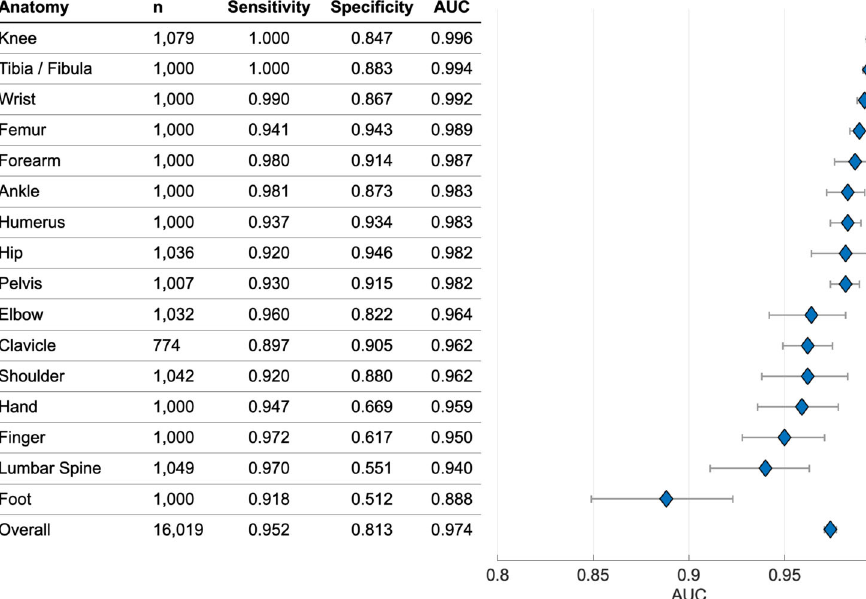
Fig. 2 The deep-learning system ’ s AUCs. Error bars represent 95% con fi dence intervals calculated using bootstrap sampling ( m = 1000). n indicates the number of radiographs